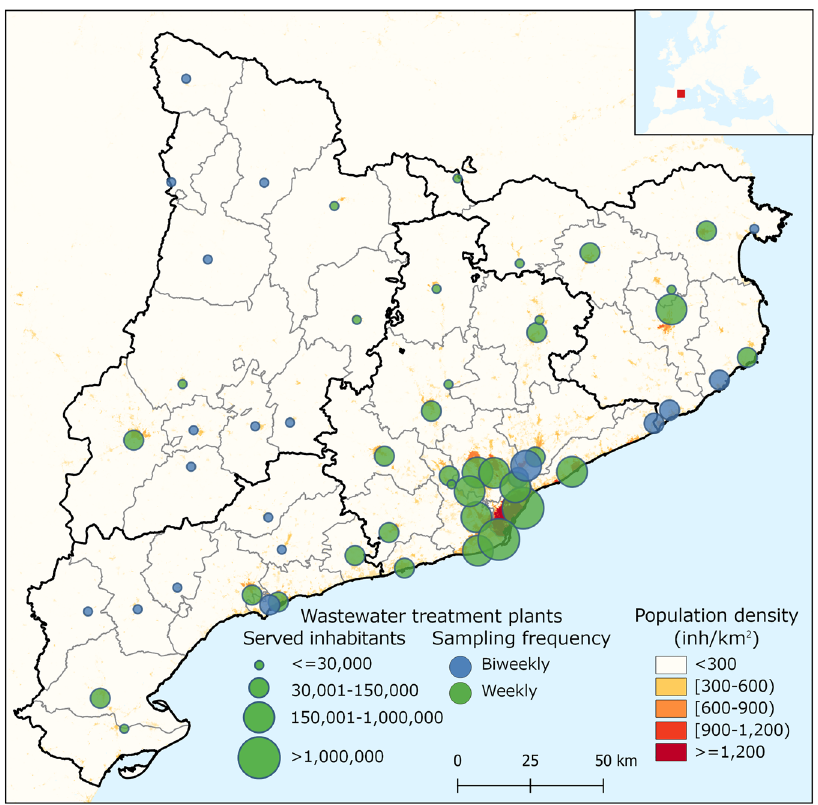
Figure 1. Map showing the location, the assisted population, and the sampling frequency of the 56 WWTPs finally selected within SARSAIGUA. Population density is shown using a grid with a resolution of 0.25 km 23 . Population density information was obtained from the Global Human Settlement Population Grid 2015 (European Joint Research Center, https:// ghsl. jrc. ec. europa. eu/ ghs_ pop. php). The main map has been built using QGIS 3.22 (https:// www. qgis. org/ en/ site/) and county limits obtained from the Cartographic and Geological Institute of Catalonia (https:// www. icgc. cat/ ca/ Desca rregu es/ Carto grafia- vecto rial/ Divis ions- admin istra tives). The upper map has been obtained from the ArcGIS Hub using ESRI data (https:// hub. arcgis. com/ datas ets/ esri:: world- count ries- gener